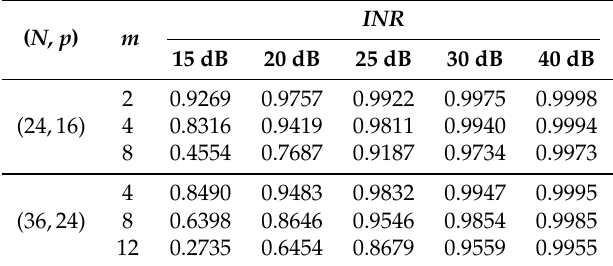
Table 1. Probability γ that p lowest cells are homogeneous in the interference environment.